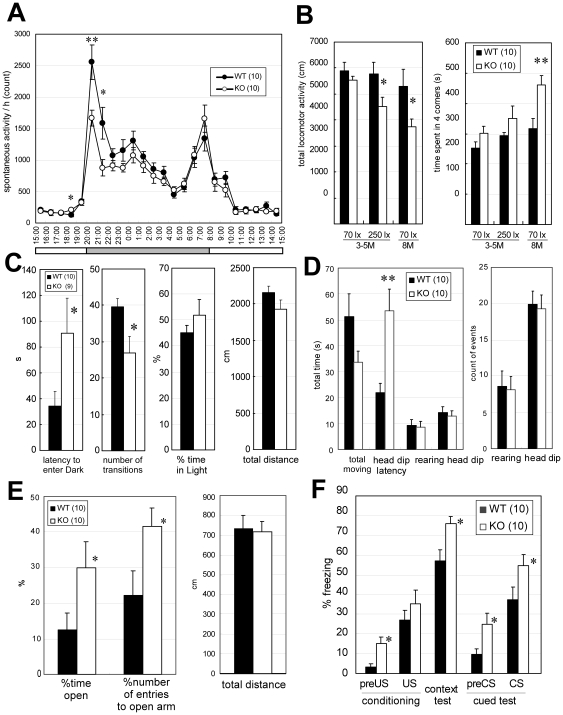

Lrrtm1 KO mice show adaptive behavior abnormalities.(A) Home-cage activities. The circadian profile of the locomotor activity (bin  = 1 h) was first determined for each mouse. Then the mean and SEM of the locomotor activities per 1 h were calculated for each genotype. Statistical analysis was performed against the mean values for each mouse. The horizontal bar below the graph indicates the light–dark cycle (gray, dark phase; white, light phase). Values are presented as means ±SEM. * P<0.05; ** P<0.01. (B) OF test. (left) The locomotor activity indicates the total distance traveled (cm) in the test period. (right) Time spent in the four corner squares of a 5×5 subdivision of the field. Young adult mice (3 to 5 months (M)) that were new to the OF apparatus were subjected to the test at two different illuminances (70 lx or 250 lx, 3–5 M). Eight-month-old mice that had experienced several behavioral tests were also tested at 70 lx illuminance (70 lx, 8 M). Values are presented as means ±SEM. * P<0.05. (C) light–dark box transition test. Total distance traveled, % of time spent in the light box, number of transitions between the light and dark boxes, and the first latency period before entering the dark box are indicated as means ±SEM. * P<0.05. (D) Hole board test. Total moving time (s), latency until head-dipping (s), number of head-dips, duration of head-dips (s), duration of rearing (s), and number of rearings are indicated as means ±SEM. ** P<0.01. (E) Elevated plus maze test. Total distance traveled, % time spent in the open arms, and % of entries to the open arms were measured. Values are presented as means ±SEM. * P<0.05 in U-test. (F) Fear-conditioning test. In both contextual and cued (conditional) tests, Lrrtm1 KO mice exhibited significantly greater freezing responses than WT mice. * P<0.05; U-test. US, unconditioned stimulus; CS, conditioned stimulus. The numbers in parentheses in the key boxes indicate those of WT and KO mice used in each experiment (common to all figures).